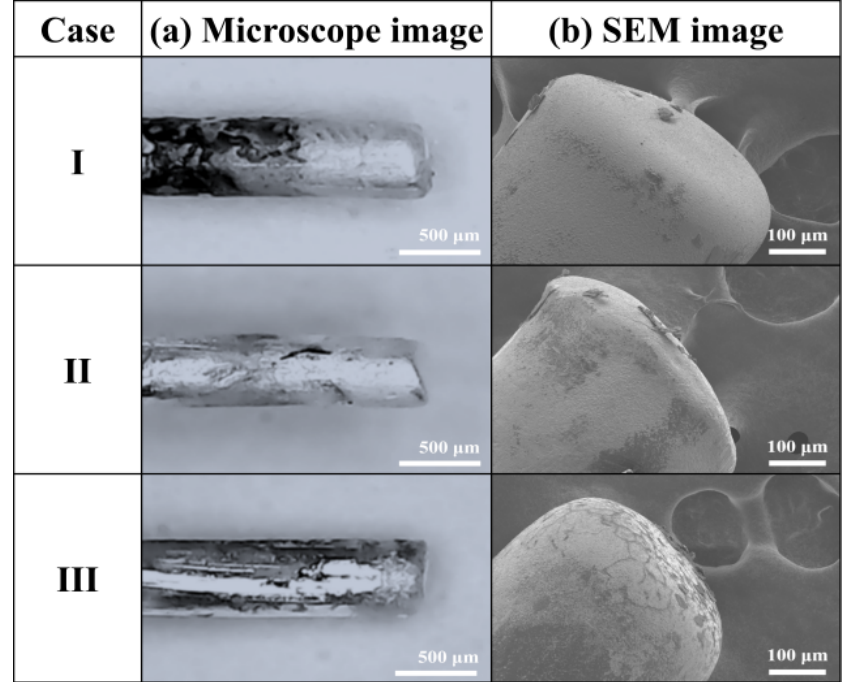
Figure 10. ( a ) Microscope and ( b ) SEM images of changes in Ag electrode tips exposed to discharges after 10 ‐ min LPP with three different bubble formations induced by adjusting pulse